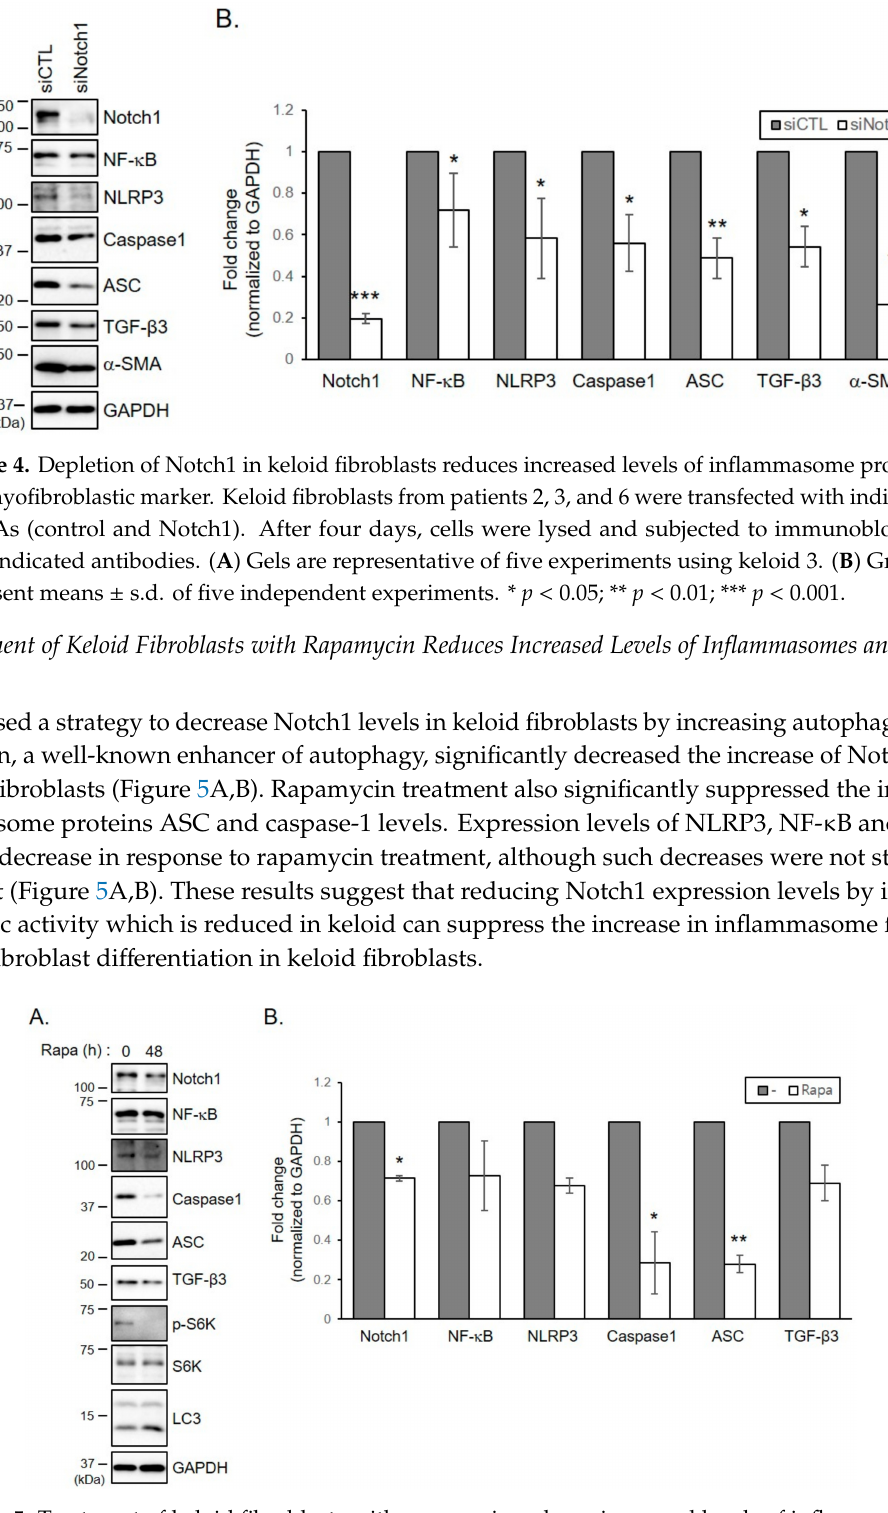
Figure 5. Treatment of keloid fibroblasts with rapamycin reduces increased levels of inflammasome proteins and TGF- β 3. Keloid fibroblasts from patients 2, 3, and 6 were seeded and incubated with 0.1 µ M of rapamycin (Rapa). Forty-eight hours later, cells were lysed and subjected to immunoblotting with indicated antibodies. ( A ) Gels are representative of five experiments using keloid 2. ( B ) Graphs represent means ± s.d. of five experiments. * p < 0.05; ** p <